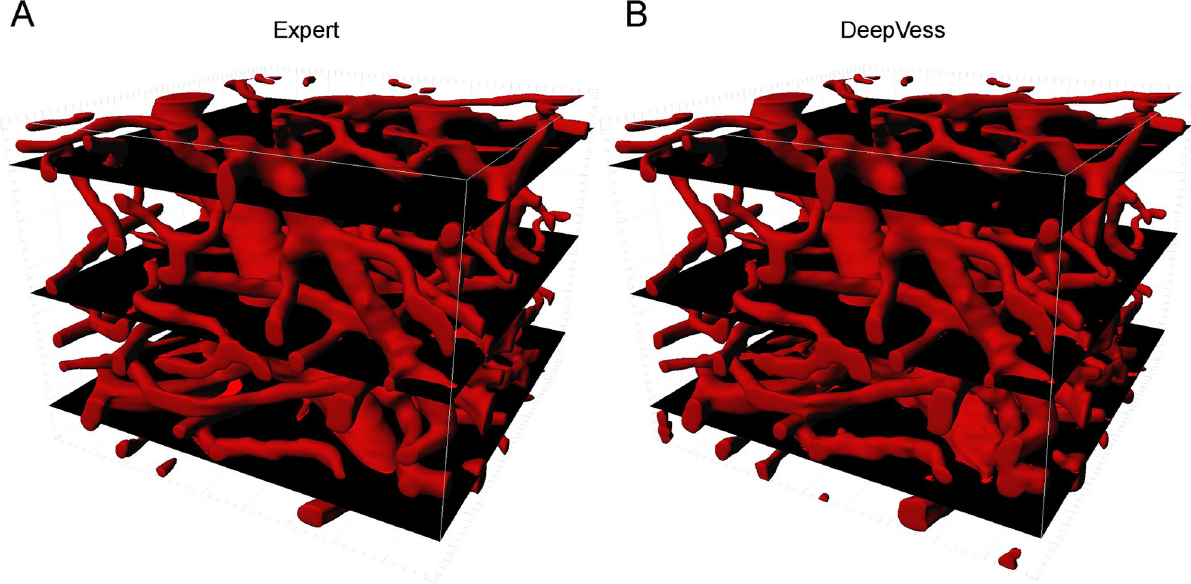
Fig 5. 3D rendering of (A) the expert’s manual and (B) DeepVess segmentation results. The top, middle, and bottom black plains correspond to the high, medium, and low quality examples, respectively, which are analyzed further in the Discussion (Fig 6). Each volume is 256 × 256 × 200 voxels (292 × 292 × 200 μm 3